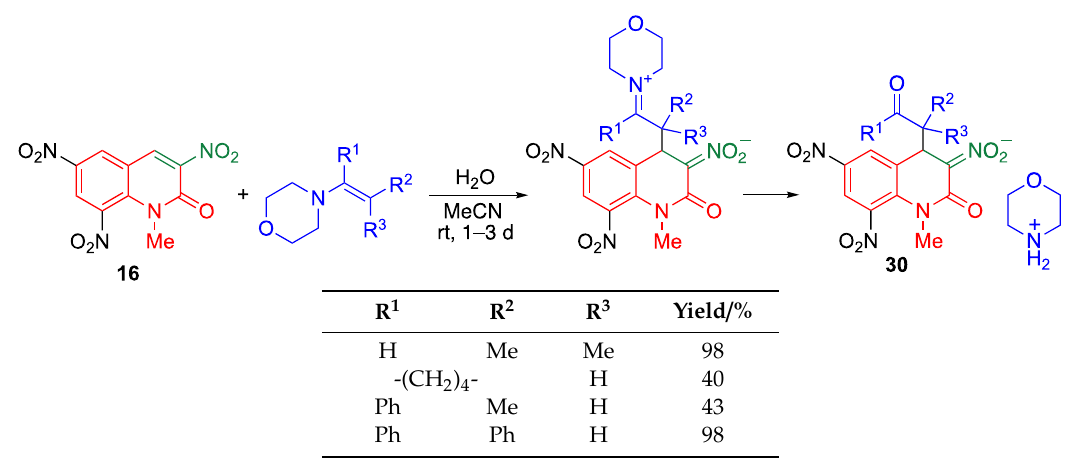
Table 10. cine -Substitution of 16 with enamines.